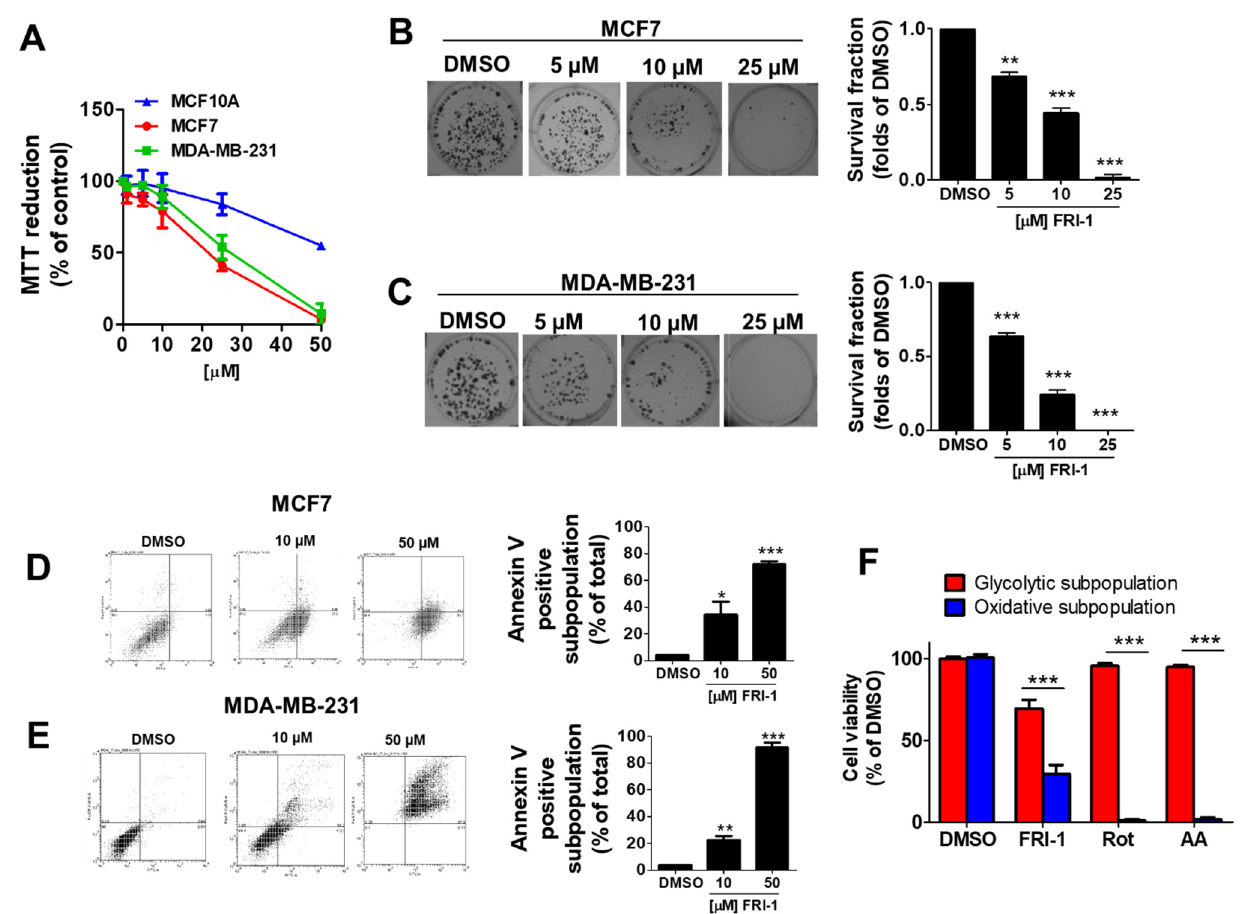
Figure 2. FRI-1 reduces the viability and clonogenic capacity of breast cancer cells. ( A ) Effect of FRI-1 on the viability of breast cancer cell lines (MCF7 and MDA-MB-231) and non-tumoral breast cell line (MCF10A) at 48 h of treatment measured by MTT assay; ( B , C ) Effect of FRI-1 on the clonogenic capacity of BC cells; ( D , E ) Determination of the percentage of apoptotic subpopulations in BC cells induced by FRI-1 at 48 h of treatment by Annexin V/PI assay; ( F ) Effect of FRI-1 (25 µM), rotenone (Rot, 1 µM) and antimycin A (AA, 1 µM) in glycolytic and oxidative subpopulations of MDA-MB-231 cells at 48 h of treatment. Viability was measured by MTT assay. The data shown are the mean ± SD of three independent experiments. * p < 0.05, ** p < 0.01, *** p < 0.001, vs. control (DMSO).